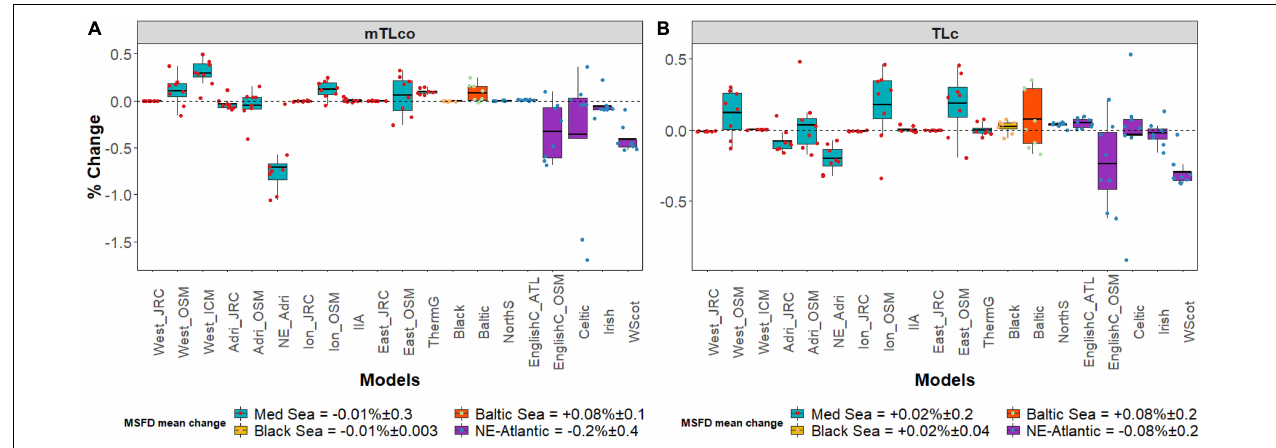
FIGURE 3 | Box plots representing the mean change (%) and standard deviation for TL indicators: (A) Mean trophic level of the community (mTLco); (B) Mean Trophic Level of the Catch (TLc) for every MSFD region/sub-region and smaller areas within an MSFD region/sub-region (the acronyms correspond to those given in Table 1 ). Yearly modeled data points are plotted as colored